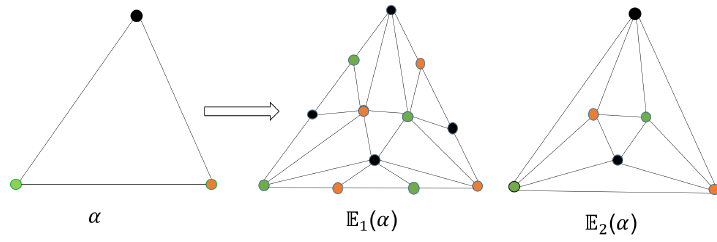
Figure 6. Once 1-type and 2-type chromatic subdivision of 2-simplex α